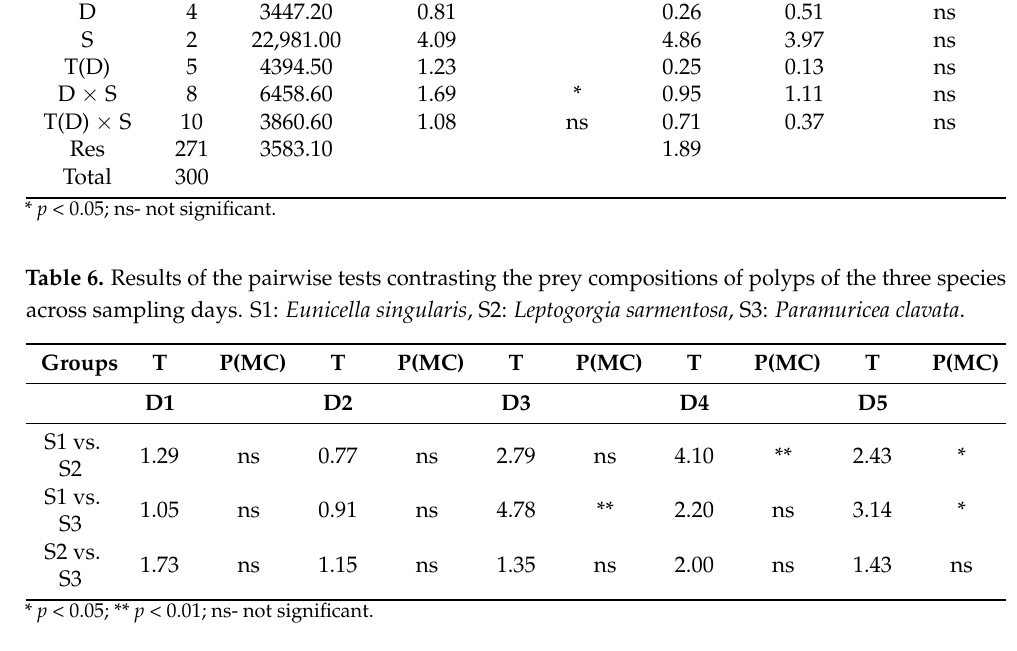
Table 5. Results of permutational analyses (PERMANOVA) on prey composition, and prey biomass of polyps of the three species investigated across several temporal scales (Day, Time).